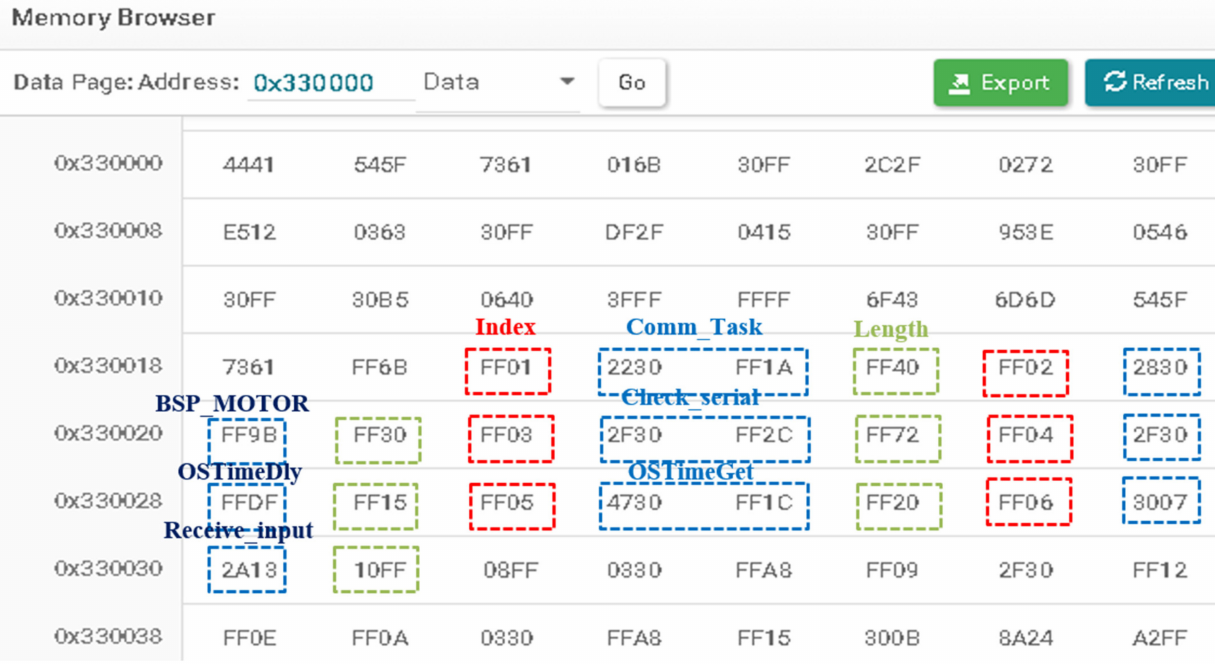
Figure 4. A call graph stored in